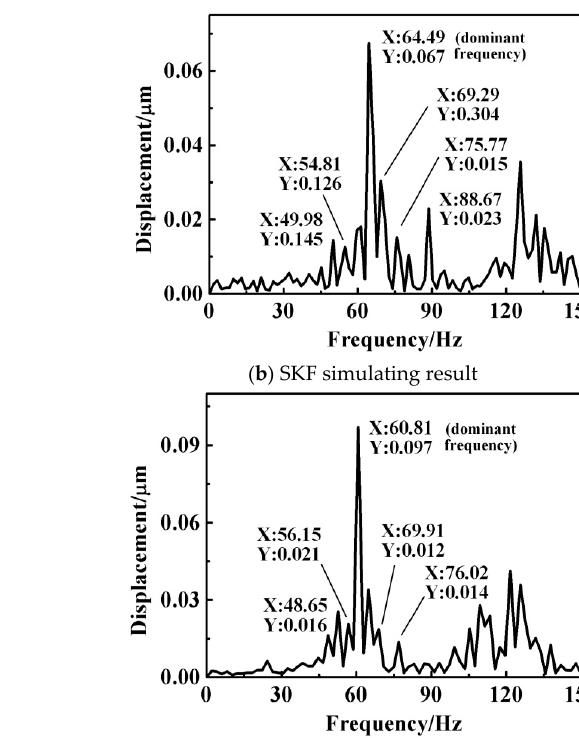
Figure 21. The motion orbits of SRBs with type 22215 from different manufacturers under adaptive self ‐ aligning operating conditions.